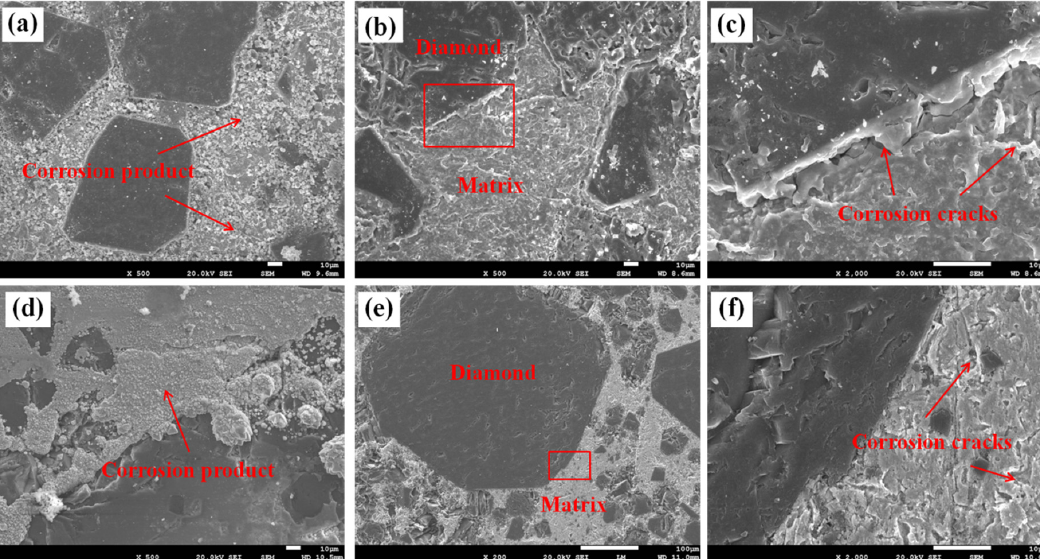
Figure 2. SEM image of 60 vol% Diamond/Cu composites containing ( a ) and removing ( b ) corrosion products; ( c ): partial enlargement of ( b ); SEM image of 75 vol% Diamond/Cu composites containing ( d ) and removing ( e ) corrosion products; ( f ) partial enlargement of ( e ). Optical images and SEM images of the gold-plated Diamond/Cu composites’ corroded surfaces after salt spray corrosion for 168 h are shown in Figure 3. The gold-plated layer on the surface of the